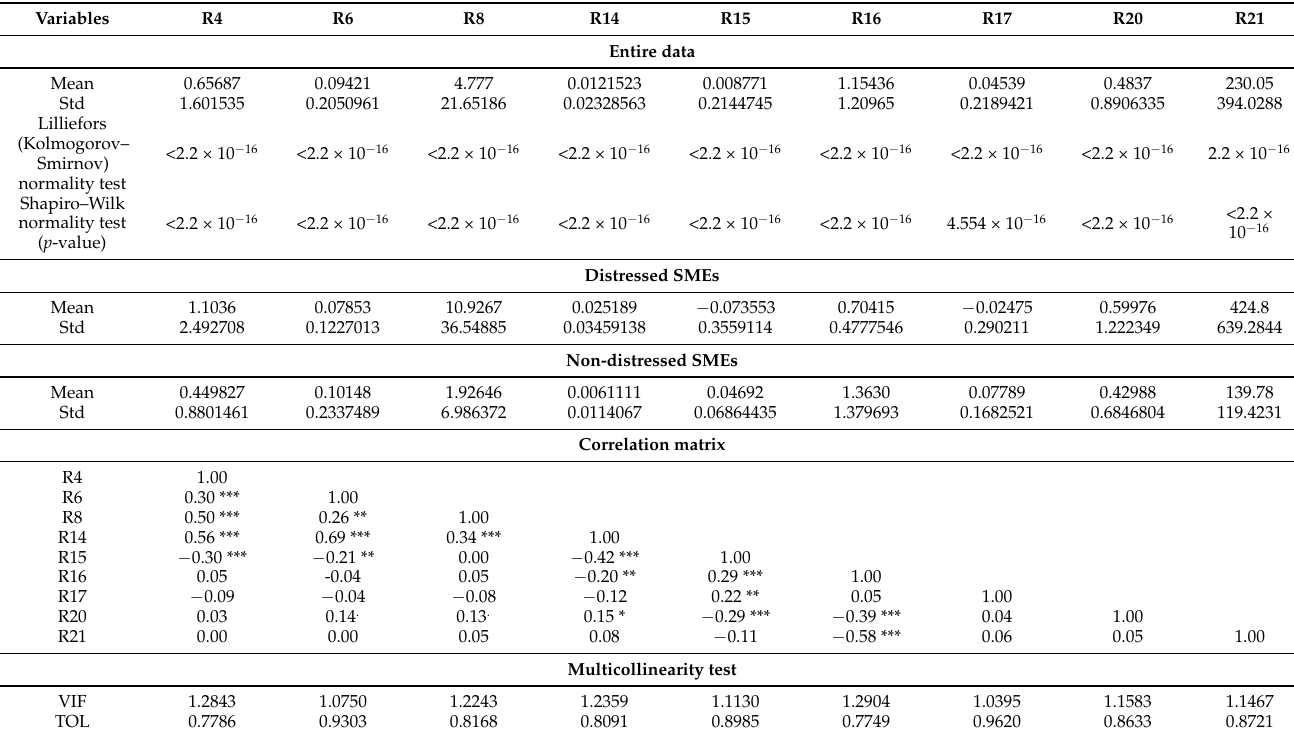
Table A4. Descriptive statistics for variables selected by lasso technique, year 2018.